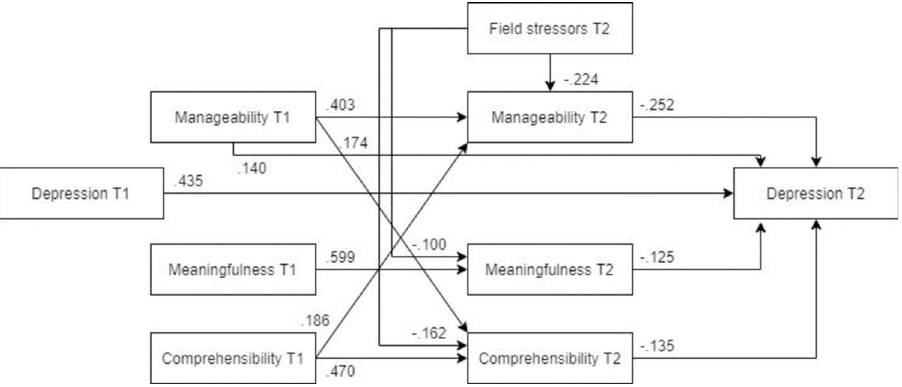
Fig 7. Optimized structural equation model for